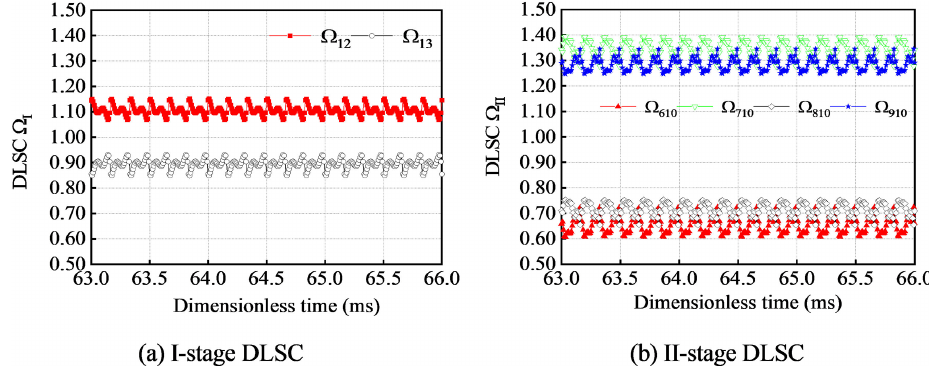
Figure 11. DLSC changed with dimensionless time.